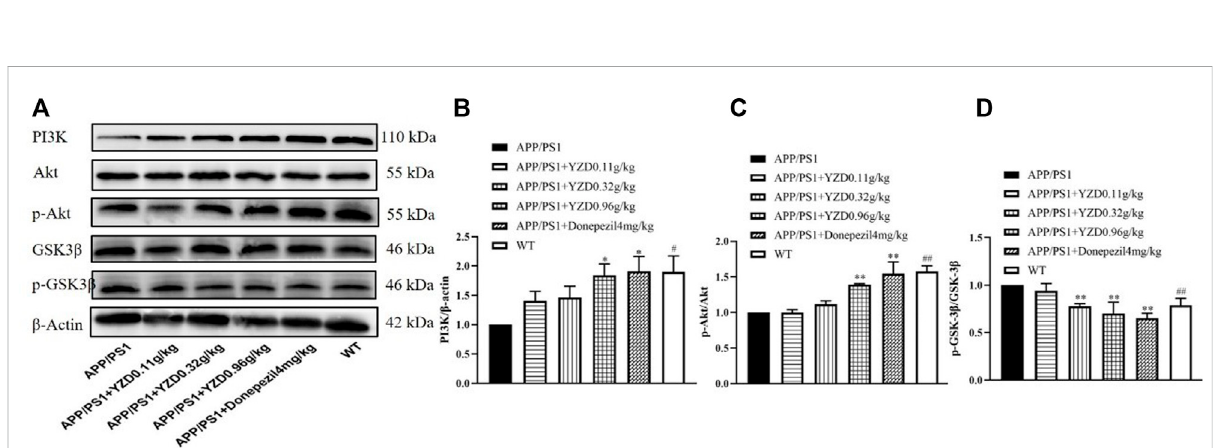
FIGURE 8 Effects of 3-months of YZD treatment on the expression of PI3K/AKT/GSK-3 β pathway related proteins in the hippocampi of APP/PS1 mice. (A) WesternblotanalysisofPI3K,AKT,p-AKT,GSK-3 β ,p-GSK-3 β . (B) DensitometryofPI3K, (C) Densitometryofp-AKT/AKT, (D) Densitometryofp-GSK- 3 β /GSK-3 β . Values show the mean ± SE ( n = 3), differences in the level of signi fi cance are: *p < 0.05, * *p < 0.01, # #p <